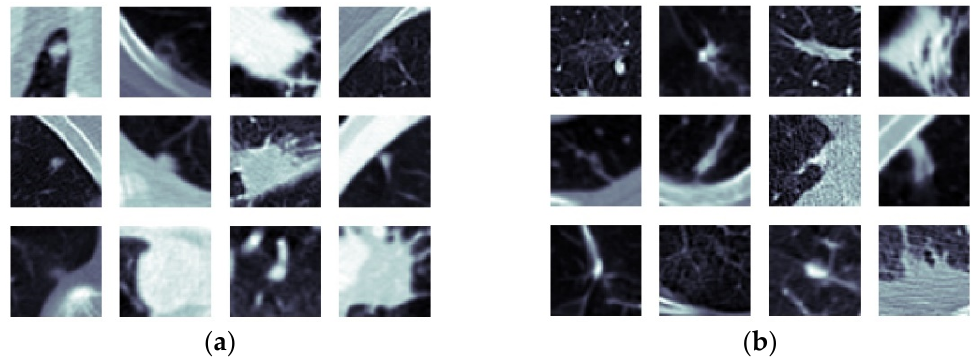
Figure 13. ( a ) MPF model—missed nodules (FN) and ( b ) MPF model—missed non-nodules (FP).